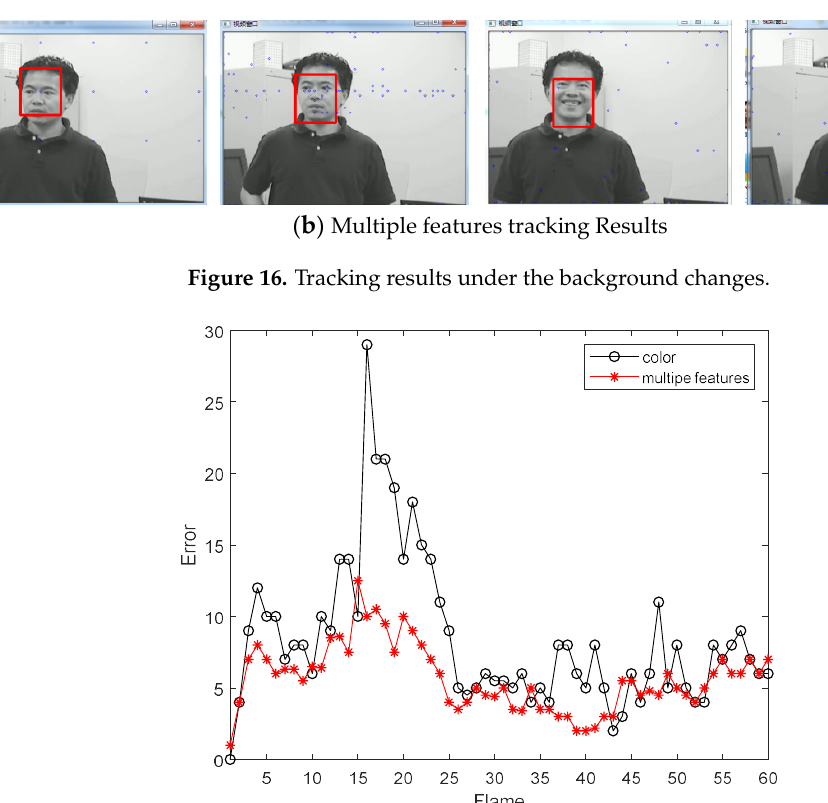
0 Figure 18. The RMSE comparison corresponding with KCF. Figure 18. The RMSE comparison corresponding with KCF.